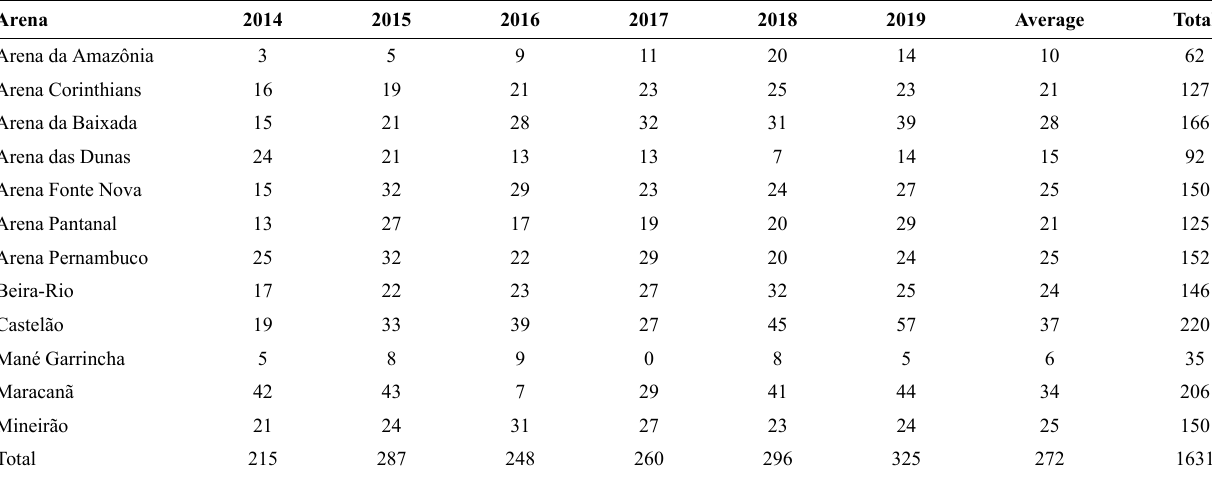
Table 8 - Consolidated arena usage for the 2014-2019 seasons.